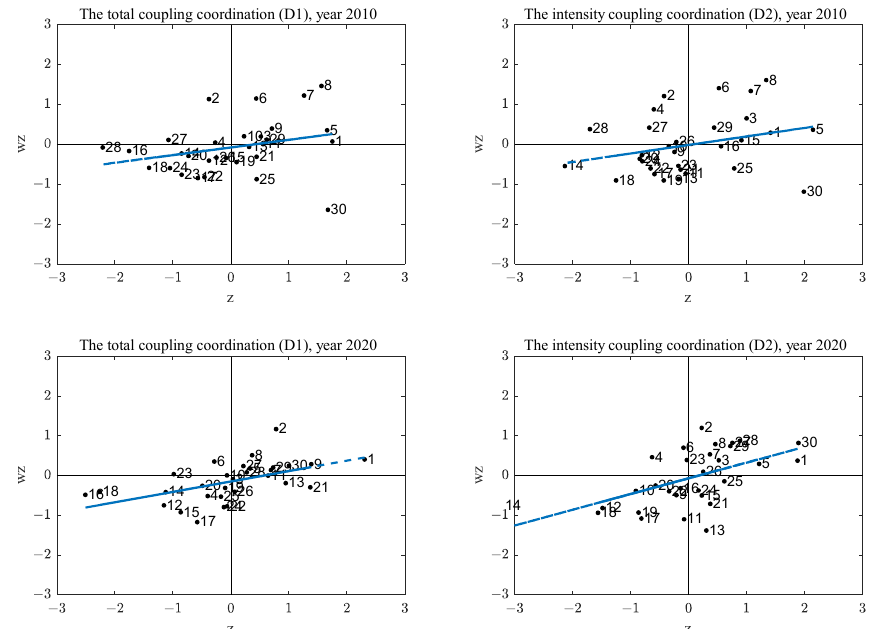
Figure 8. Moran scatterplot of coupling coordination degree. Note: 1–30 represent: 1 Beijing, 2 Tian- jin, 3 Hebei, 4 Shanxi, 5 Inner Mongolia, 6 Liaoning, 7 Jilin, 8 Heilongjiang, 9 Shanghai, 10 Jiangsu, 11 Zhejiang, 12 Anhui, 13 Fujian, 14 Jiangxi, 15 Shandong, 16 Henan, 17 Hubei, 18 Hunan, 19 Guang-